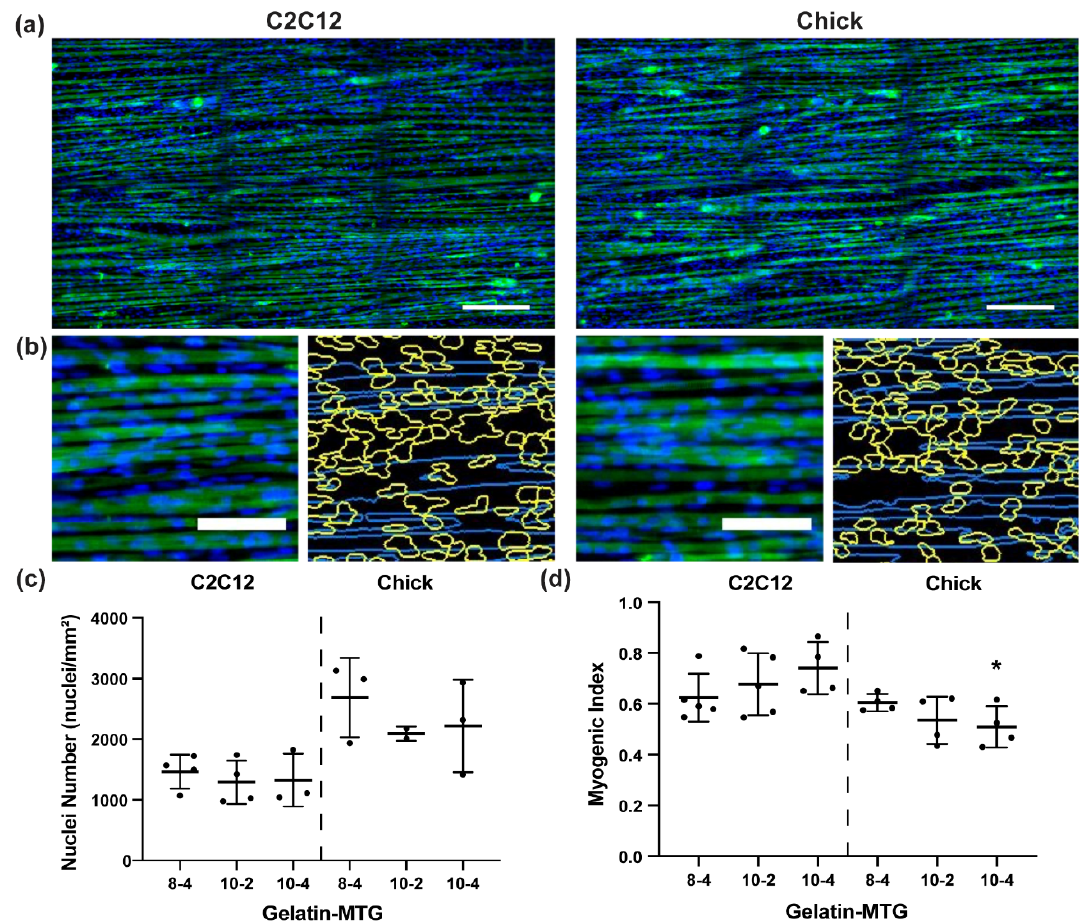
Figure 6. ( a ) Representative images of C2C12 and chick tissues stained for α -actinin (green) and DAPI (blue) on micromolded 10–2 gelatin hydrogels. Scale bar: 200 µ m. ( b ) Stained tissues before (left) and after (right) image processing, which automatically detects nuclei (yellow outlines) and myotubes (blue). Scale bar: 100 µ m. Nuclei number ( c ) and myogenic index ( d ) for C2C12 and chick tissues cultured on micromolded gelatin hydrogels with the indicated formulations. Bars indicate standard deviation, n = 3–4. * indicates p < 0.05 between C2C12 and chick tissues cultured on the same gelatin-MTG formulation based on student’s t -test.